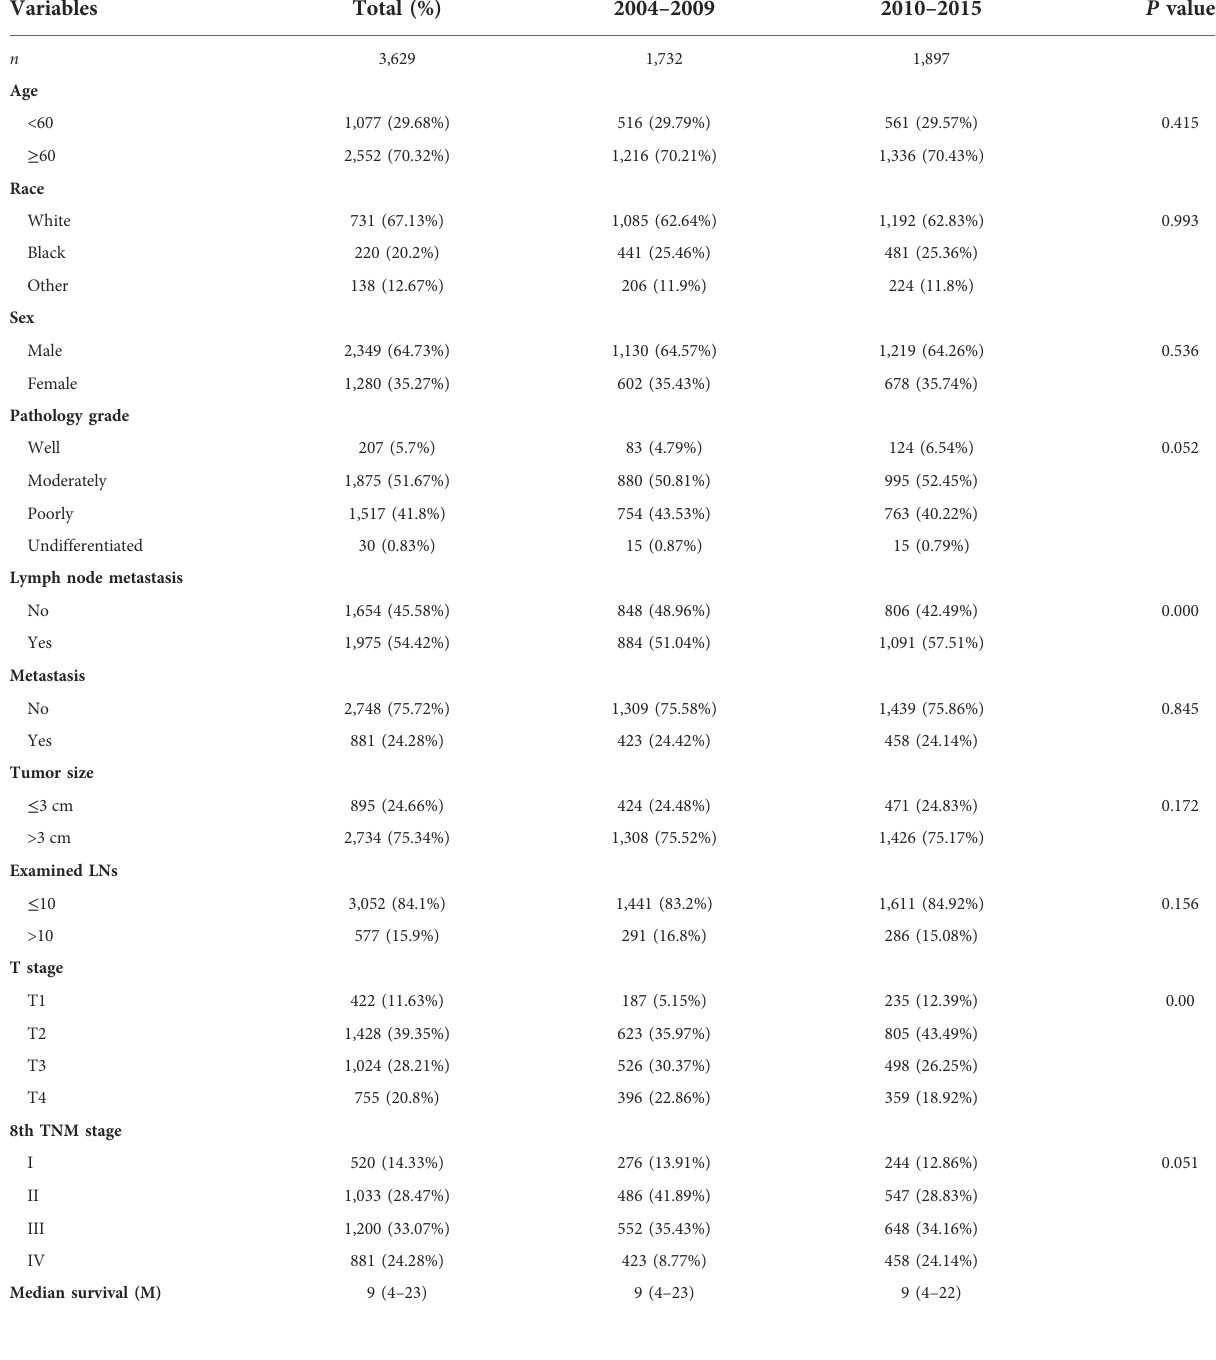
TABLE 1 Patients ’ demographics, clinical characteristics at